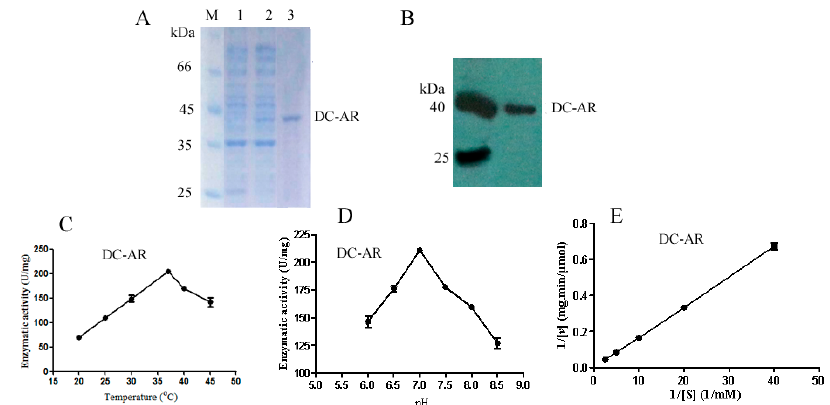
Figure 5. The enzymatic properties of DC-AT and DC-GST: ( A ) The optimal temperature for DC-AT; ( B ) The optimal pH of DC-AT; ( C ) The enzymatic kinetics of DC-AT; ( D ) The optimal temperature for DC-GST; ( E ) The optimal pH of DC-GST; ( F ) The enzymatic kinetics of DC-GST. The aldehyde reductase from D. cejpii (DC-AR) encoded by GliO was successfully expressed in E. coli BL21 (DE3) with a molecular weight of 40.0 kDa (Figure 6A), which was demonstrated by Western blot analysis (Figure 6B). The enzymatic properties of GliO were analyzed using p- nitrobenzaldehyde as a substrate. DC-AR showed the highest enzymatic activity of 204.65 ± 3.35 U/mg at the temperature of 37 °C (Figure 6C), the optimal pH for DC-AR towards p- nitrobenzaldehyde was 7.0 (Figure 6D), and the corresponding enzymatic activity was 210.94 ± 1.41 U/mg. The enzymatic kinetics of DC-AR was also investigated. The Km value of DC-AR towards p- nitrobenzaldehyde was 6.4 mM, and the corresponding Vmax was 400 μ mol·mg − 1 ·min − 1 (Figure 6E).